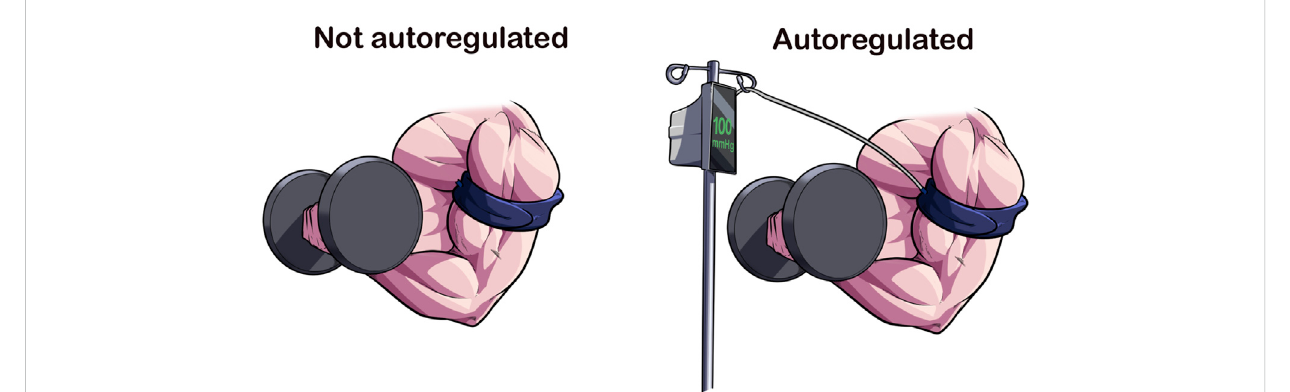
FIGURE 2 Autoregulation of Applied Pressures. Autoregulation is a design feature that accommodates for the changes in limb circumference because of muscular contraction. In current available devices, the BFR cuff is attached to a pneumatic air compressor via an air tubing that adjusts according to the pressure sensed at the cuff-limb interface. The speed at which this adjustment occurs varies across devices, making it a cuff-speci fi c feature. Autoregulation may enhance the acute safety of BFR